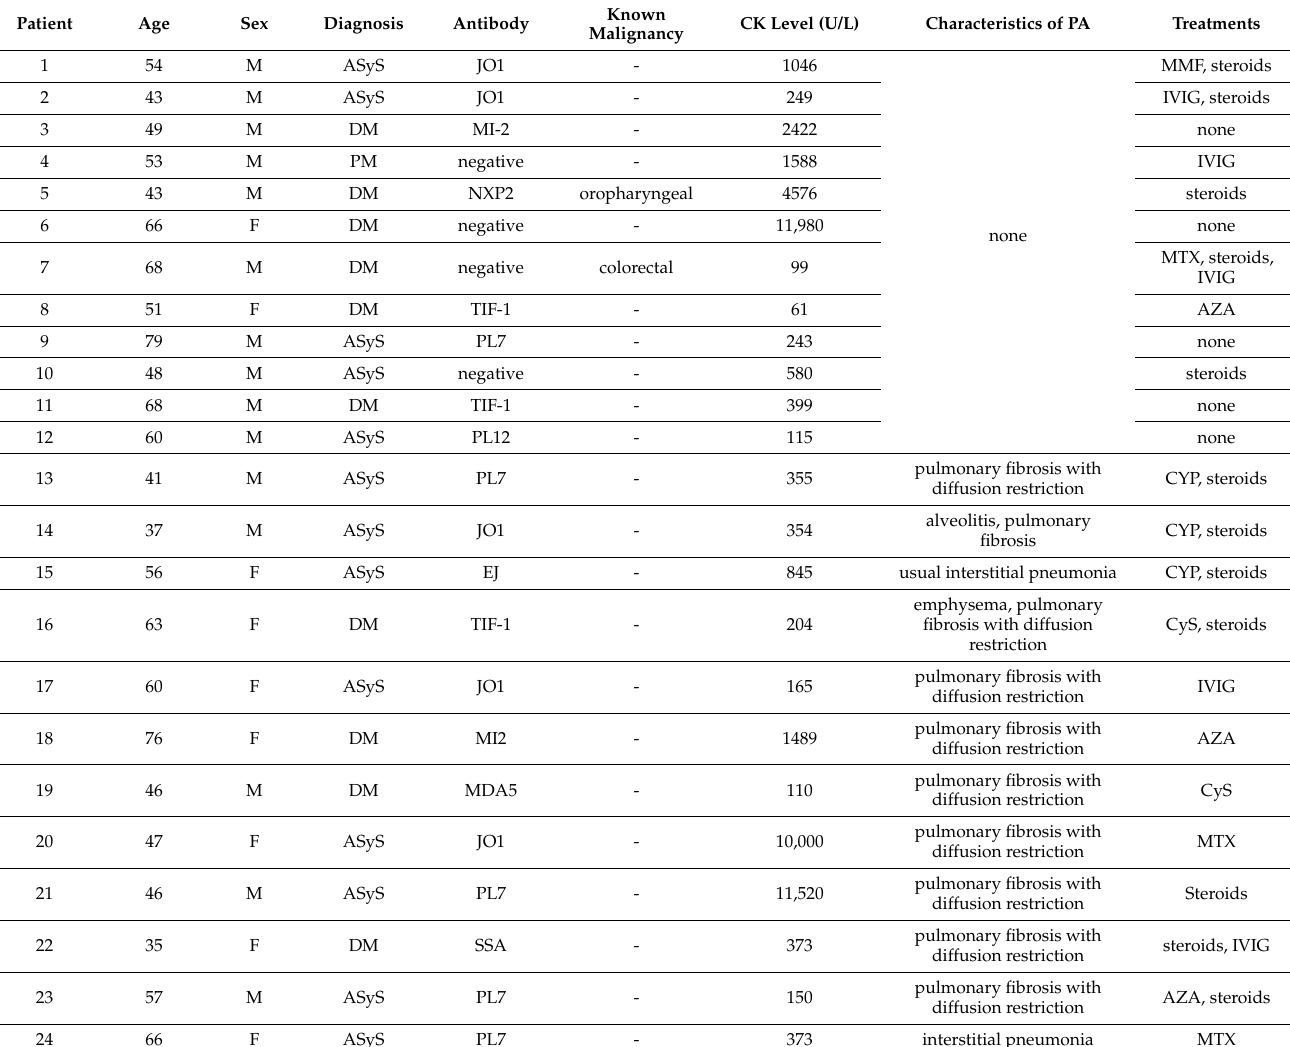
Table 1. Demographics and baseline disease characteristics. Abbreviations: AZA = azathioprine, CK = creatine kinase, CYP = cyclophosphamide, CyS = cyclosporine, F = female, IVIG = intravenous immunoglobulins, M = male, MMT-8 = manual muscle testing of 8 muscle groups, MTX =